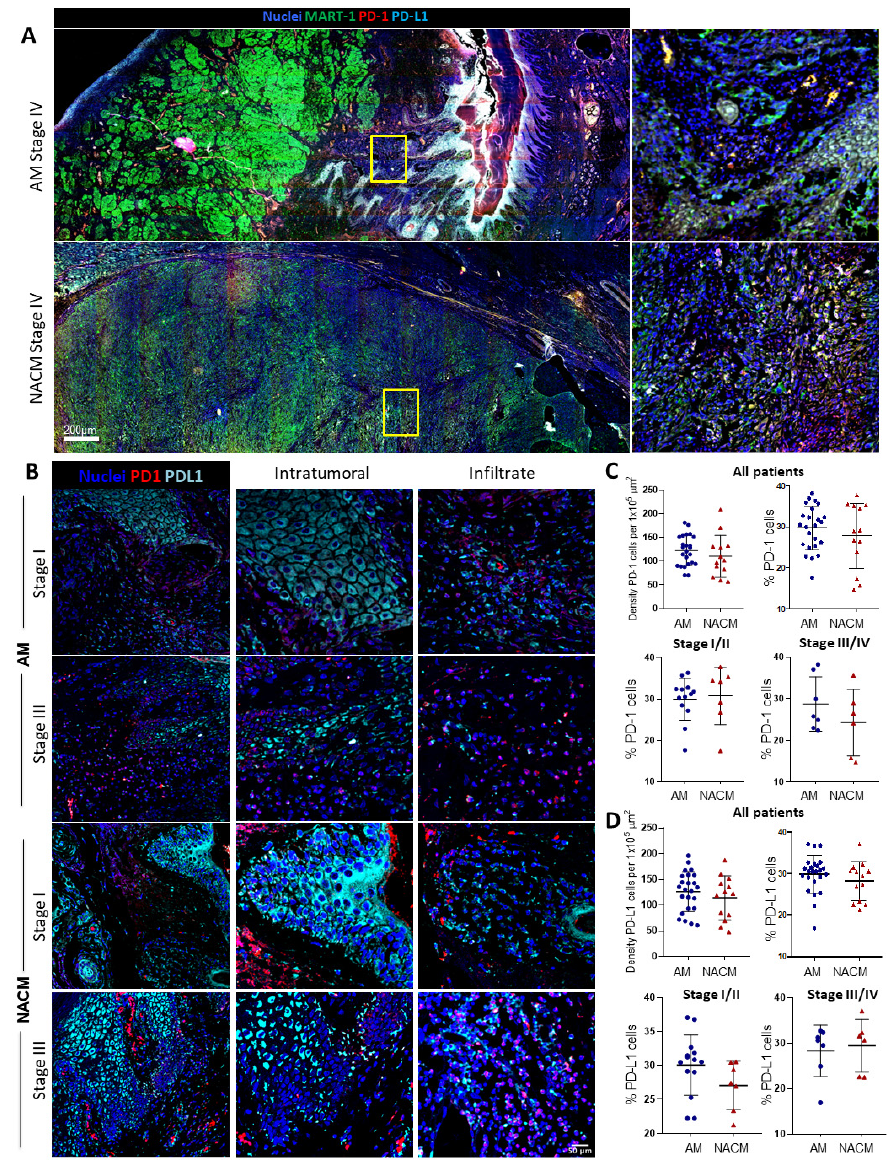
Figure 4. The PD-1/PD-L1 axis is active in acral melanoma samples. ( A ) Whole slide scanning of a representative immunofluorescence (IF) image of advanced stage IV AM (top) and NACM (bottom) showing the global distribution of PD-1 (red) and PD-L1 (cyan). IF images also show tumor cells marked with MART-1 (green) and nuclei (blue) and digital zooms (right panel, yellow squares). ( B ) Representative IF images of Stage I and III AM and NACM. Staining: PD-1 (red), PD-L1 (cyan) and nuclei (blue). Digital zooms show an intratumoral area (middle) and a highly infiltrated area (right). ( C , D ) Plots with the following comparisons between AM and NACM, ( C ) the absolute numbers of PD-1 + cells per 1 × 10 5 μ m 2 (left) and percentages (right) in all patients, percentages of PD-1 + cells in early stages I and II (bottom left) and advanced stages III and IV (bottom right). ( D ) The absolute numbers of PD-L1 + cells per 1 × 10 5 μ m 2 (left) and percentages (right) in all patients, percentages of PD-L1 + cells in early stages I and II (bottom left), and advanced stages III and IV (bottom right). Percentages of PD-1 + and PD-L1 + cells were estimated among all nucleated cells present in the highly infiltrated areas selected. Supplementary Figure S3 shows the autofluorescence control for this experiment. For this analysis, we used 38 samples from the original IMSS cohort plus five additional advanced NACM samples derived from other hospitals: AM (blue, n = 30) and NACM (red, n = 13). Statistical analysis: Unpaired Student’s t